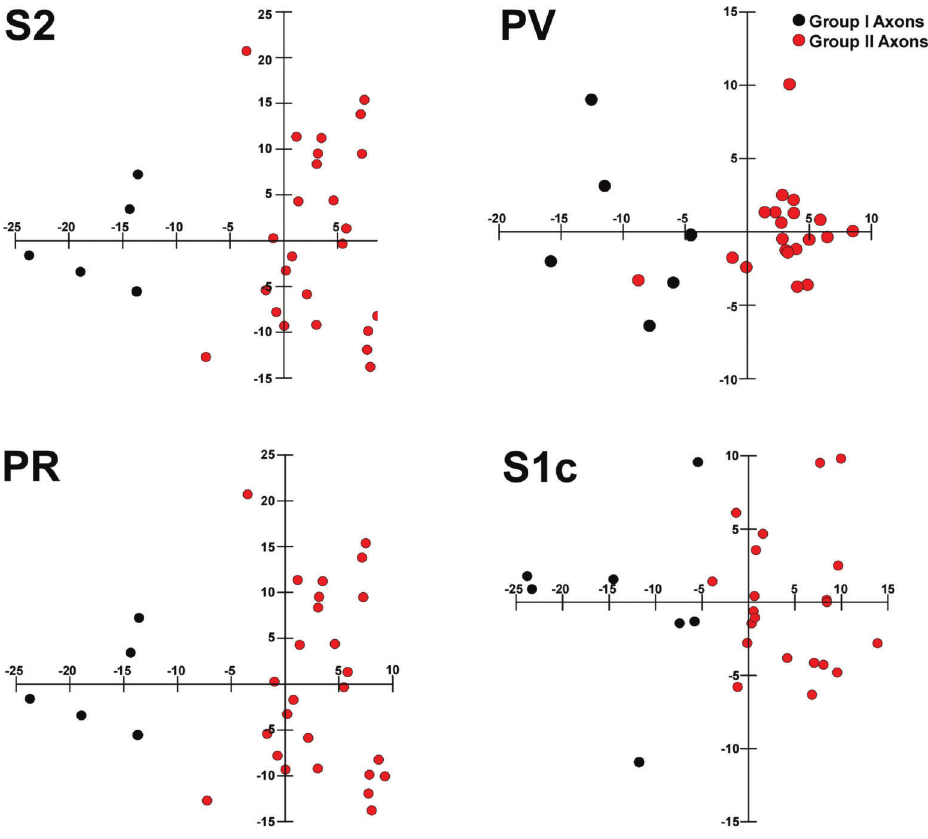
Figure 4 . Graphic results of discriminant analysis showing the separation of axon terminals from secondary somatosensory area (S2), parietal rhinal area (PR), parietal ventral area (PV) and contralateral primary somatosensory area (S1c) into two distinct groups: Group I axons (black dots) and Group II Axons (red